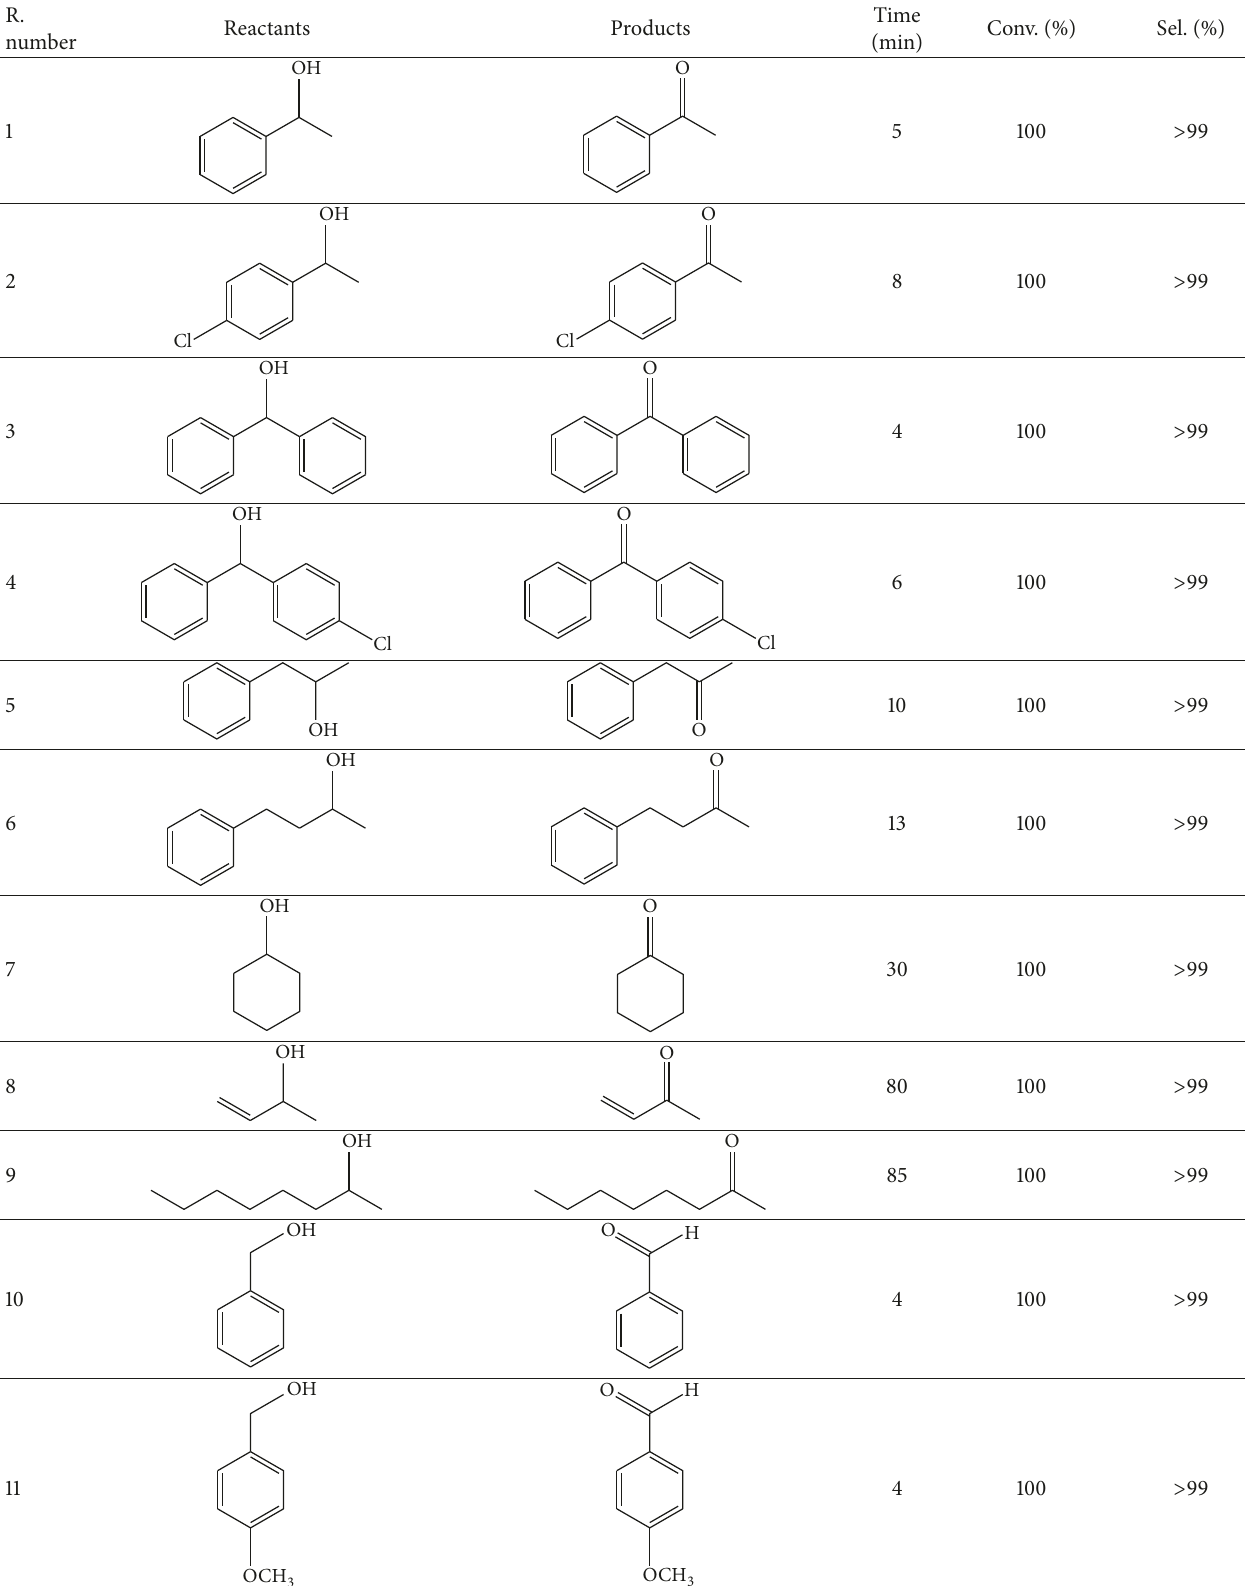
Table 6: Oxidation of different types of alcohols over 1% ZnO 𝑥 –MnCO 3 catalyst. [ a ]